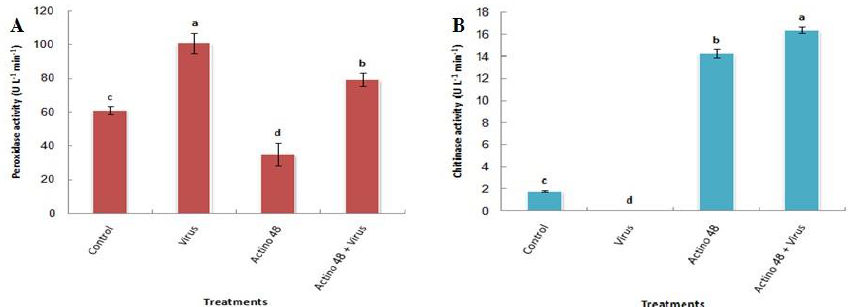
Figure 2. Effect of Streptomyces cellulosae isolate Actino 48 on the induction of ( A ) peroxidase (POD) activity and ( B ) chitinase activity in tomato leaves at 21 days post-inoculation. Columns with the same letter denote an insignificant difference.